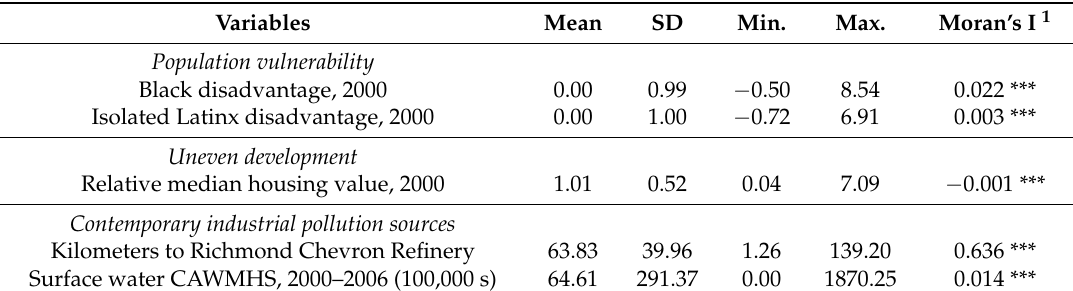
Descriptive statistics for variables used in the global logistic regression (GLR) and geographically weighted logistic regression (GWLR) analyses of block group 50 percent areal containment within a 2006, 303(d), impaired water hazard zone (N =